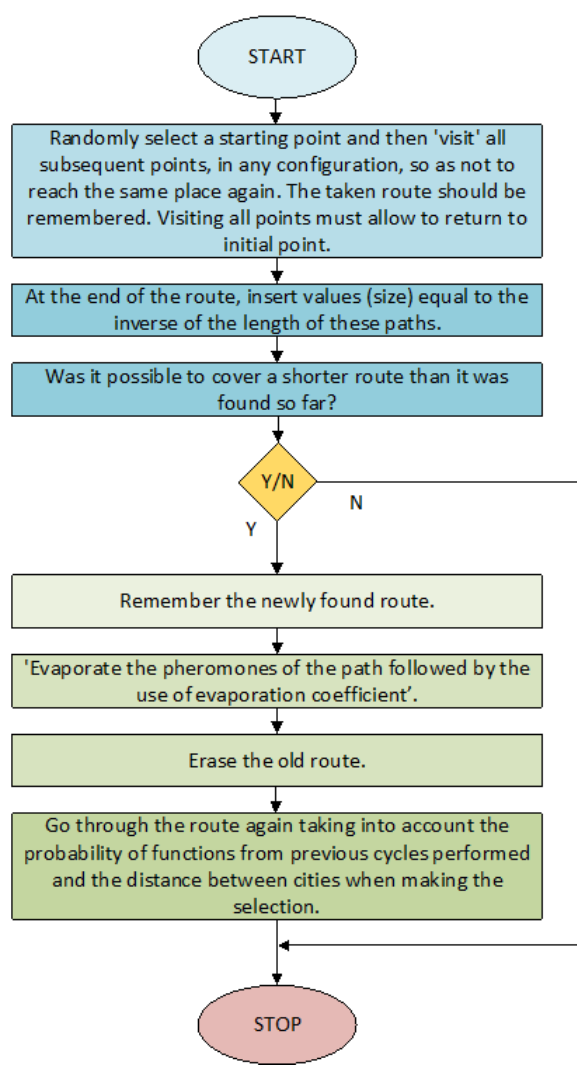
Figure 5: Diagram of operation based on form algorithm